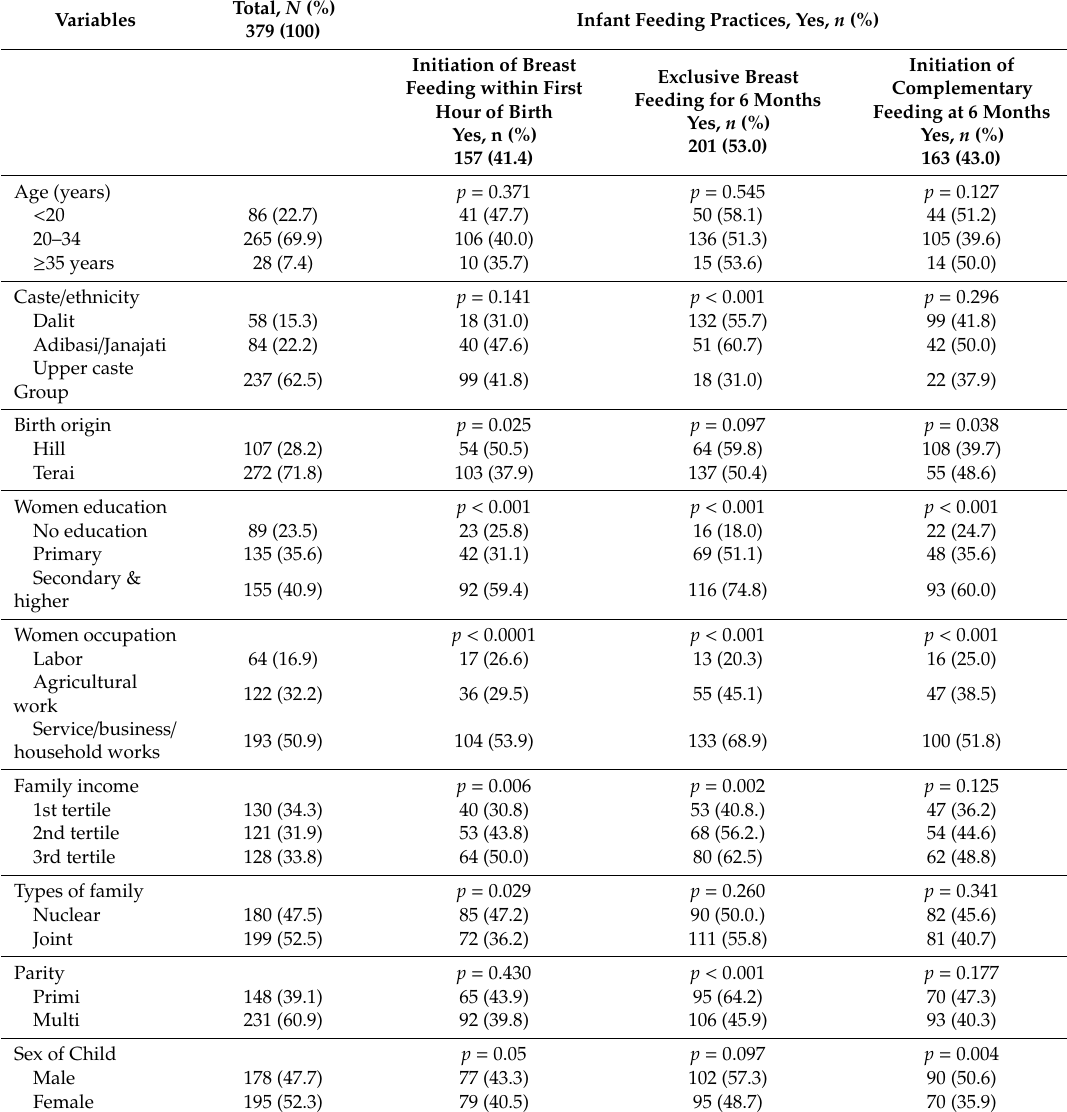
Table 2. Association between maternal characteristics of mothers and infant feeding practices in rural Southern Nepal,